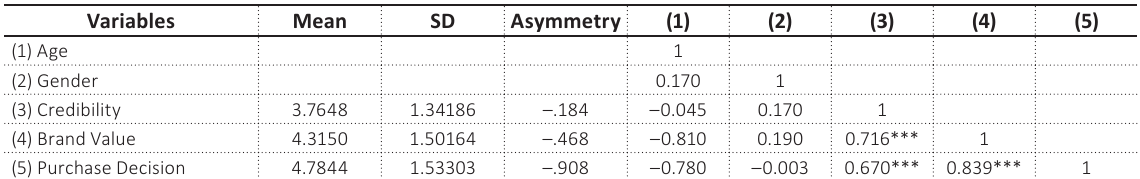
Table 1. Descriptive analysis of the study